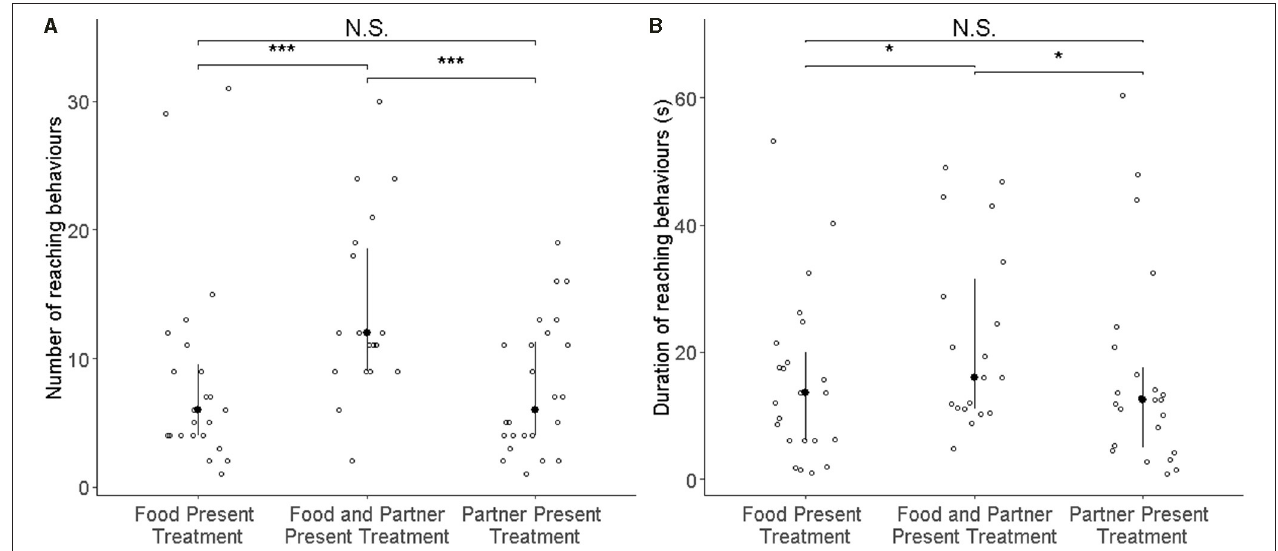
FIGURE 2 | Number of reaching events (A) and the total duration of all reaching behaviours (B) of all focal rats ( N = 25) in the test phase. Open circles represent individual data points, filled circles the median value, and whiskers the interquartile ranges. In the three treatments, either food or the partner were absent (left and right columns), or both were present (middle). Both the number of reaching events and their total duration increased significantly in the presence of both food and partner relative to the two control conditions as denoted by asterisks (*** p < 0.001, * p < 0.05).